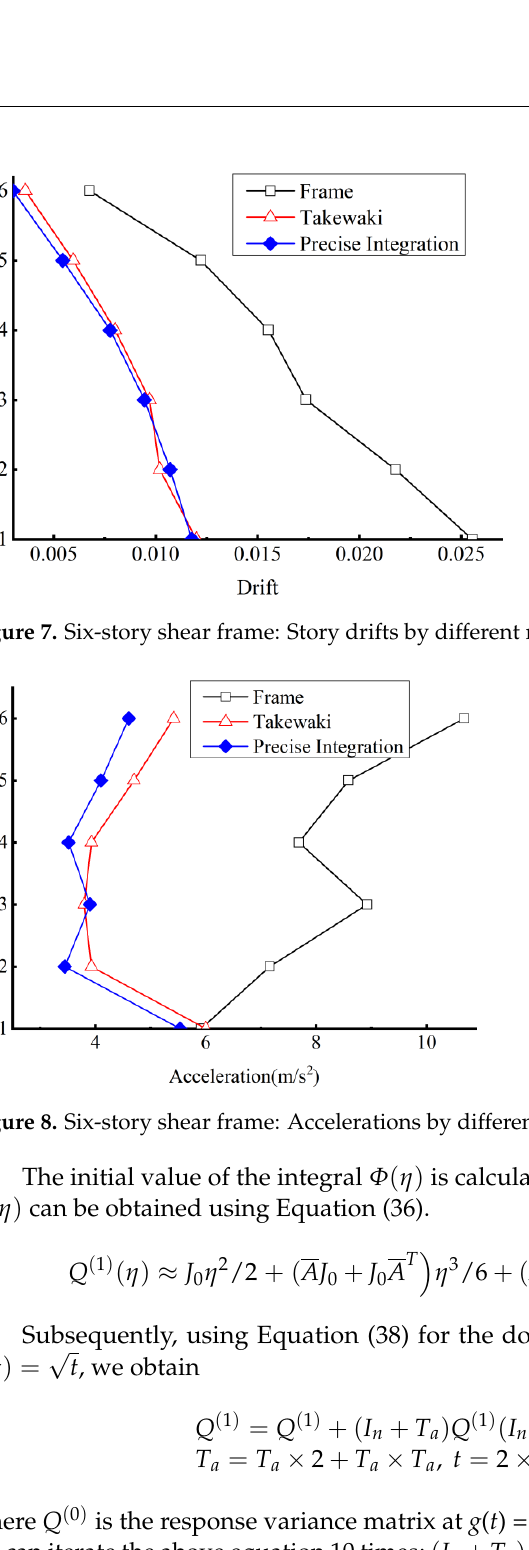
16 of 21 Figure 6. Six-story shear frame: mean squared interstory drifts before and after optimization [25]. After dissipation optimization using precise integration based on the Lyapunov differential equation, the curve of the mean square values of the interstory displacement in Figure 6 is perpendicular to the coordinate axis, which perfectly achieves the fully stressed design of the mean square value of the interstory displacement, and the results are compared with the methods in other studies. The basic data of the model and optimized additional damping ratio are used to build a finite element model, and the model is subjected to time-history analysis to extract calculated results, such as acceleration and displacement angles. By comparing the obtained interlayer drift ratios (Figure 7) and floor accelerations (Figure 8) of the